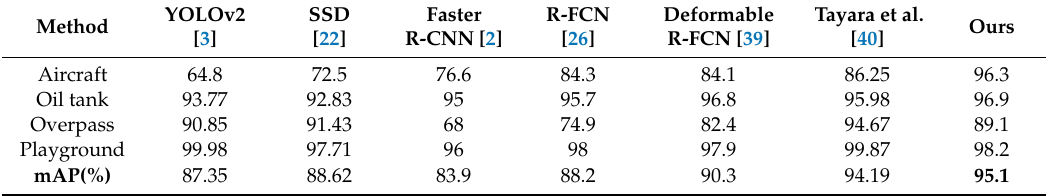
Table 7. Comparison results on the RSOD dataset. The bold numbers represent the best detection results.